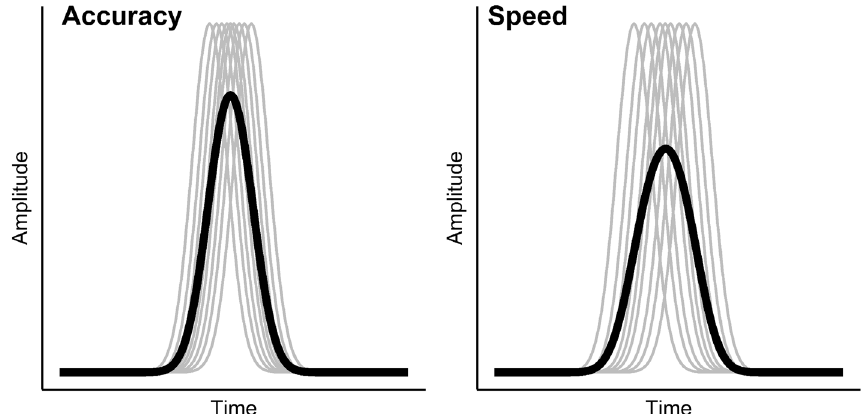
Figure 2. The Impact of Single-Trial Latency Variability on the Participant-Average Waveform. Note . The grey lines indicate single-trial waveforms, the black lines result from averaging the single-trial waveforms. In the left panel, the single-trial waveforms peak around the same point in time, hence the variability in single-trial peak latencies is small and the resulting average waveform has a comparatively high peak amplitude. In the right panel, the variability in single-trial latencies is much larger and as a consequence, the resulting average waveform has a lower peak